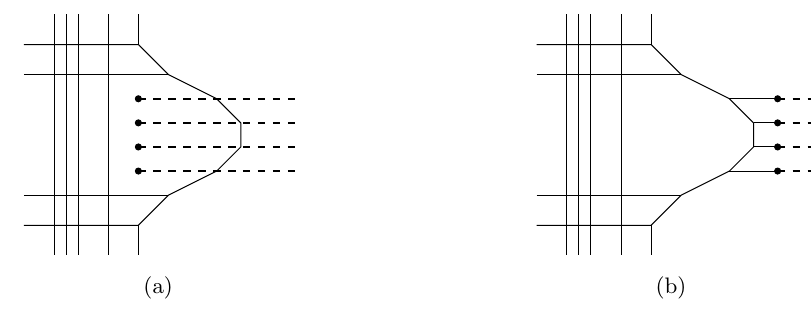
Figure 6 . Starting from the web shown in (cid:12)gure 4(c), where the branch cut of each 7-brane is crossed by only one 5-brane, and moving the 7-branes out of the web, produces a pure 5-brane web with no avoided intersections. Vertically aligning the D7-branes in the web on the right hand side with the external D5 branes turns the web into an intersection of D5 and NS5 branes. This deformation corresponds to a change of the (cid:13)avor masses; the conformal UV (cid:12)xed point, which is described by the supergravity solution, remains the